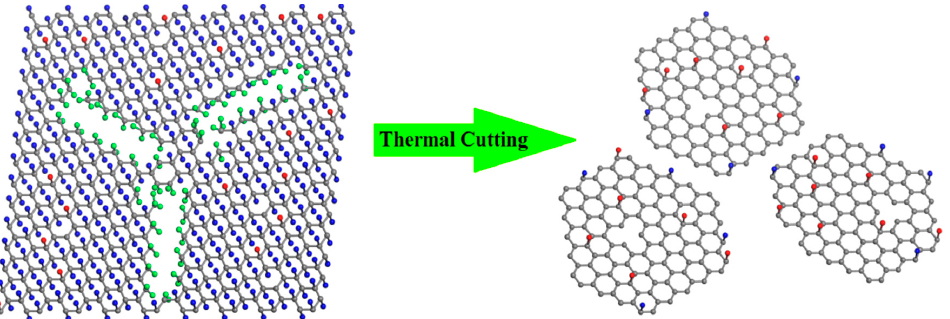
Figure 3. Schematic illustrations for GQDs-F through a novel thermal cutting of fluorinated graphene. The left is FG with a number of structure defects, characterizing by a high percent of C–F n ( n = 2, 3) bonds. The bonded F atoms of C–F n ( n = 2, 3) groups are highlighted by green balls, and other F adatoms are shown as blue balls. Carbon skeleton atoms and O-contained groups are shown as grey and red balls, respectively. When the annealing temperature is high enough, FG can be completely cut into scattered graphene quantum dots ( Right ).